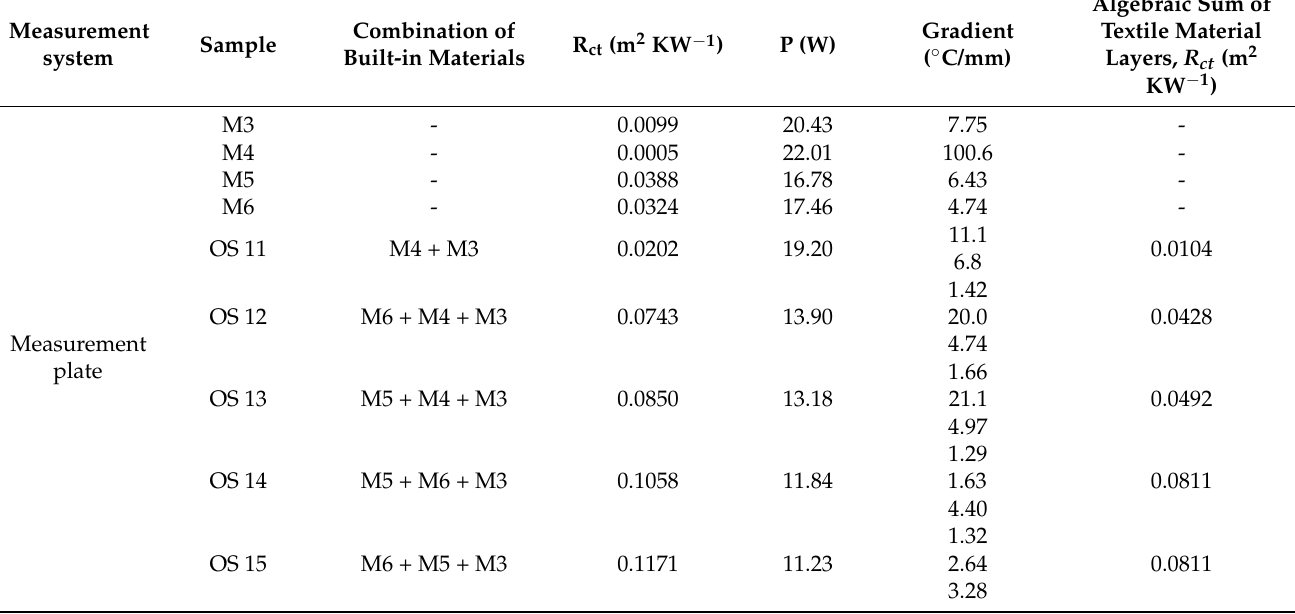
Table 3. Results for the Measurement and Calculation of the Thermal Resistance for Component Textile Materials, Layers of Composite Clothing and Realized Jackets; the Electrical Power Required to Maintain Thermodynamic Equilibrium, the Calculation of the Temperature Gradients and the Algebraic Sum of the Thermal Resistance for all Textile Material Layers in the Composite Clothing are also Shown.